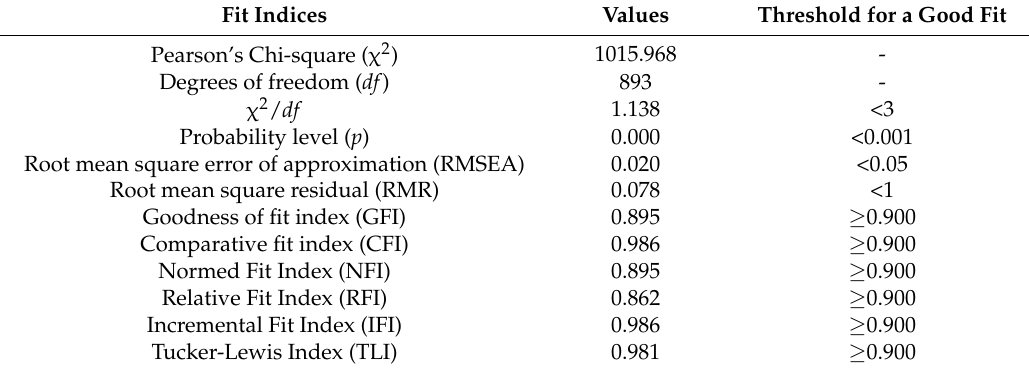
Table 3. Fit Indices.